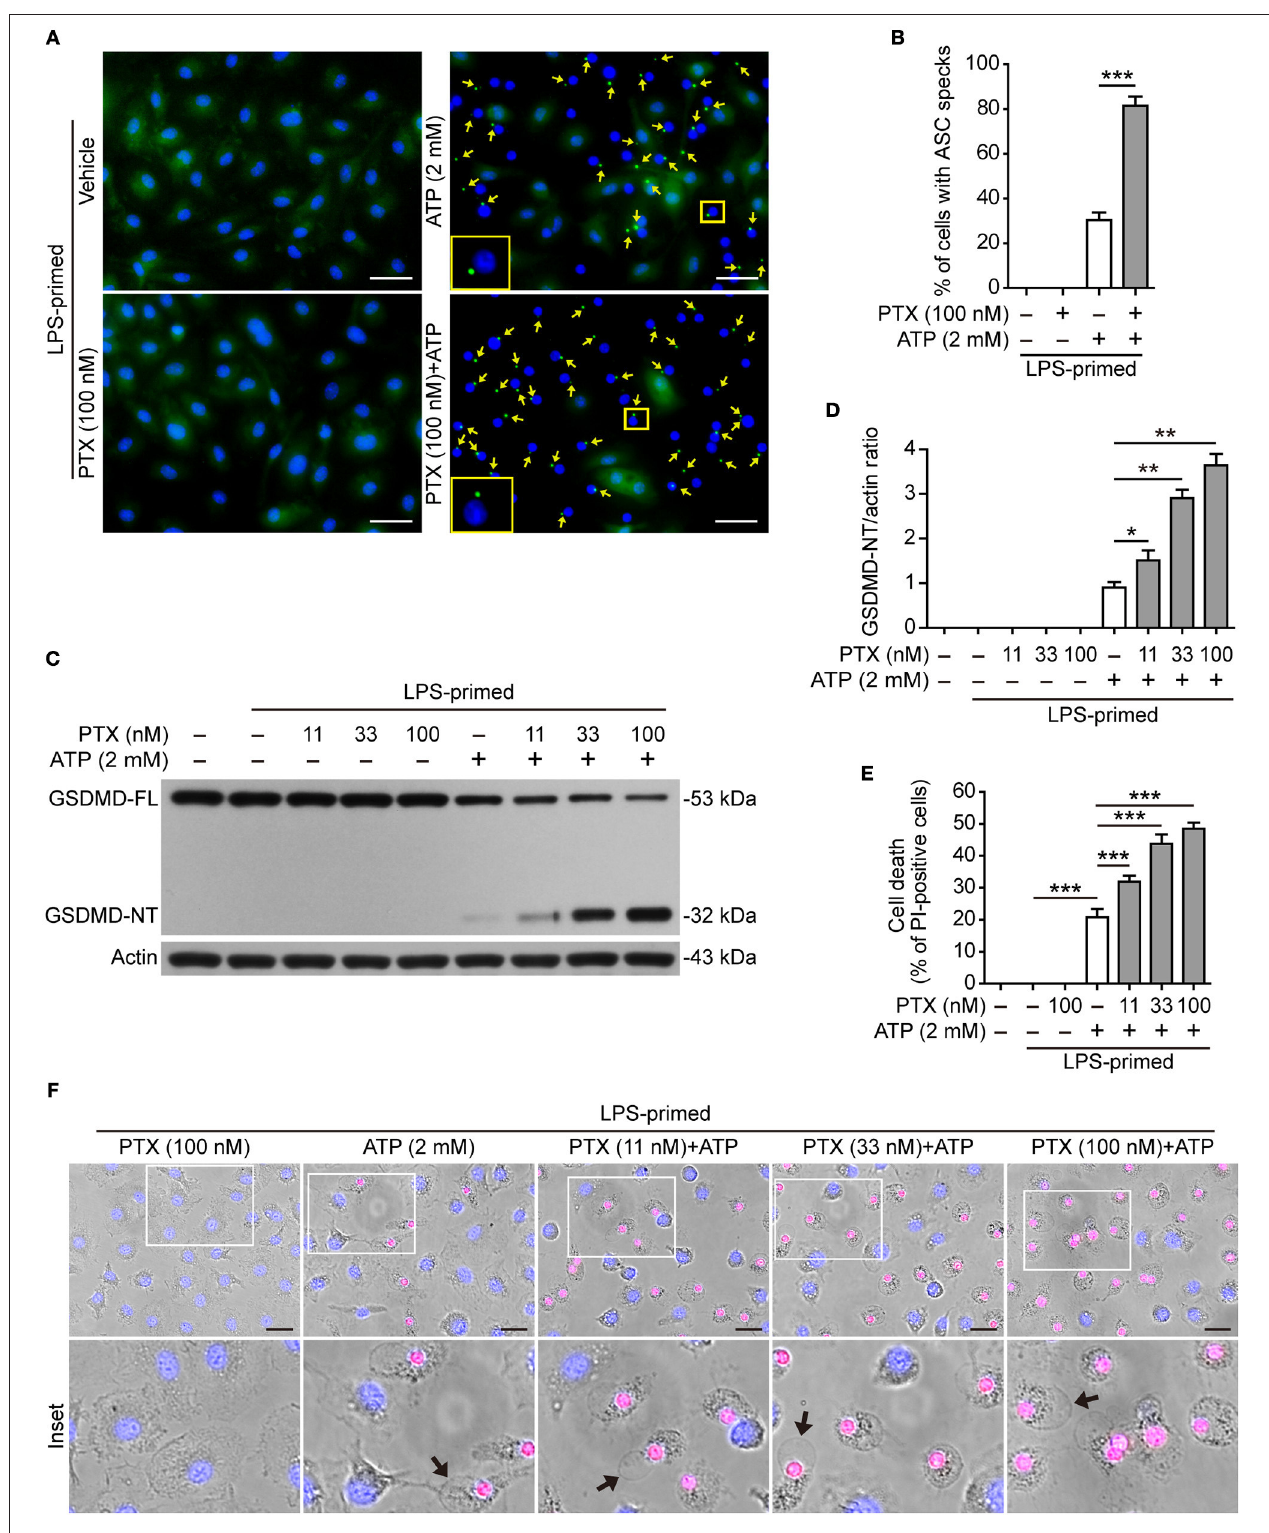
FIGURE 2 | Paclitaxel increased ATP-induced ASC speck formation and pyroptosis in bone marrow-derived macrophages (BMDMs). LPS - primed BMDMs were pre-treated with indicated concentrations of paclitaxel for 1h, followed by incubation with ATP (2mM) for 30min without LPS. (A) ASC expression and subcellular distribution were revealed by fluorescence microscopy. Representative images (40 × ) showing ASC (green) subcellular distribution. Nuclei were revealed by Hoechst